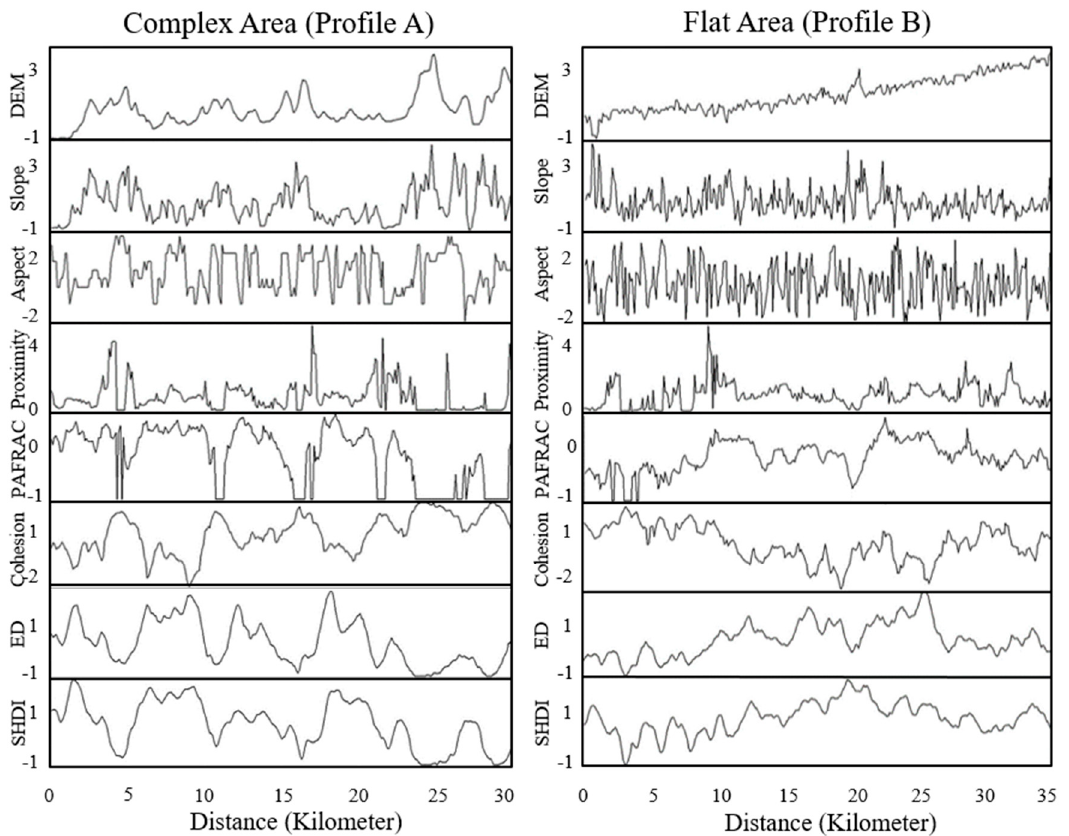
Figure 2. The variations of topographical factors and landscape indices after zero-mean normalization in profiles ( A ) complex area and ( B ) flat area.